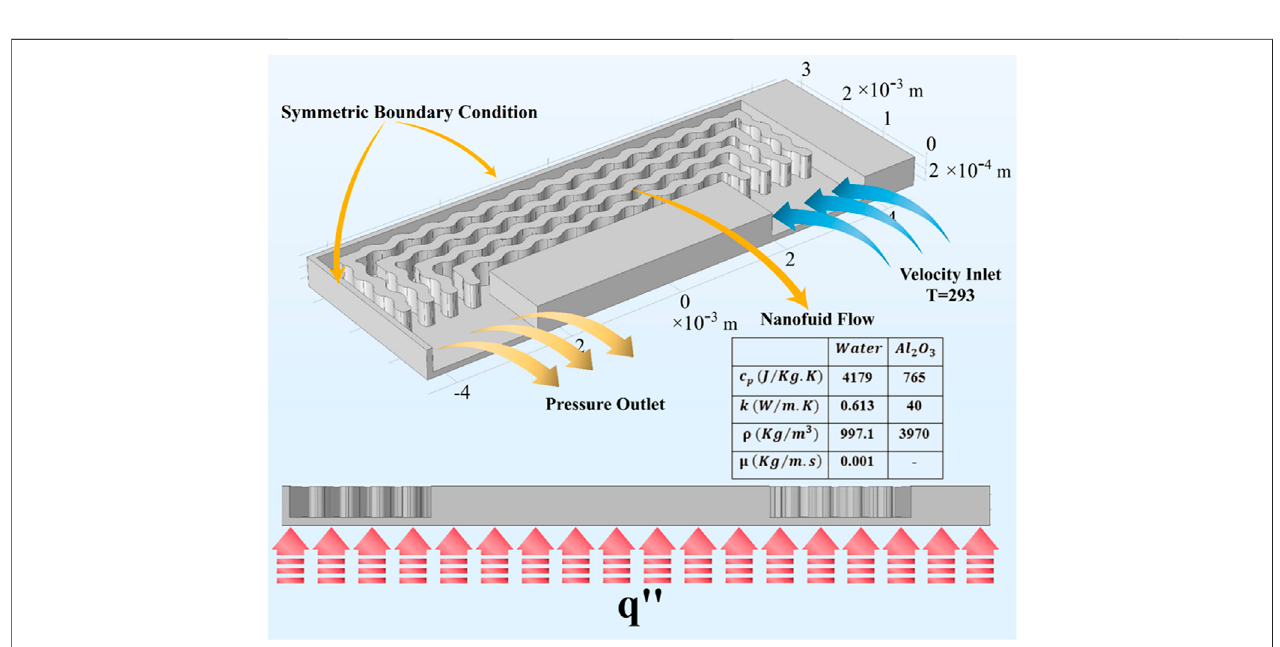
FIGURE 2 | Boundary conditions applied to the problem geometry and thermophysical properties of H 2 O and Al 2 O 3 NPs.